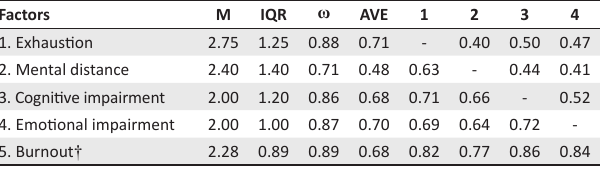
TABLE 2: Descriptive statistics, omega reliability, average variance extracted and correlation matrix with shared variances. Factors